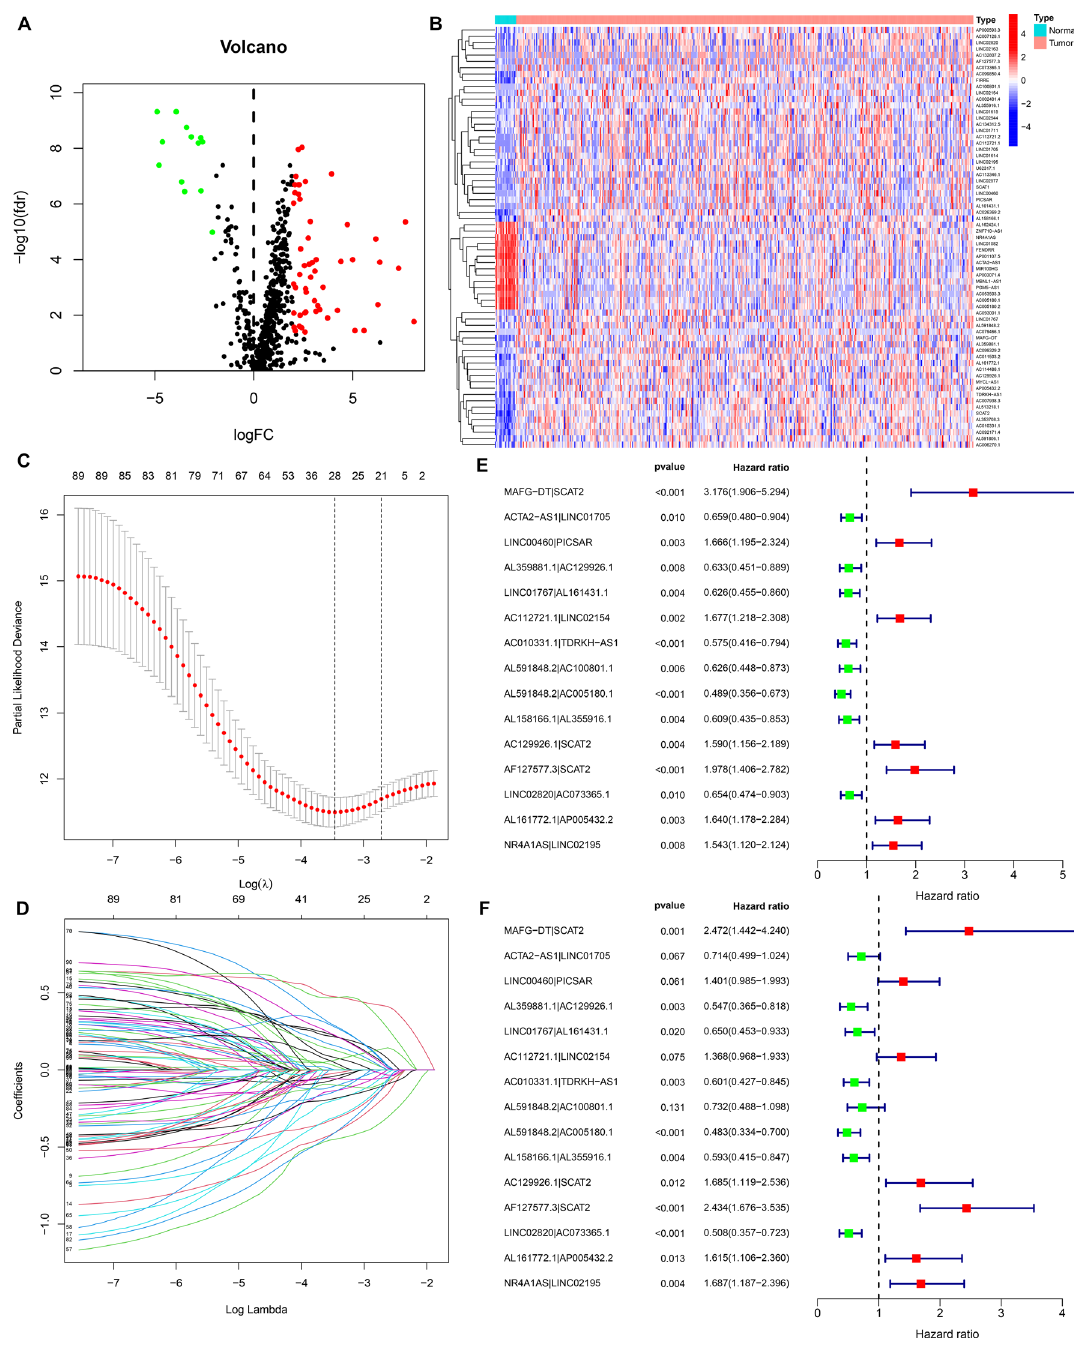
Figure 2. Developing a prognostic immune-related lncRNA signature for bladder cancer. ( A ) Volcano diagram of immune-related lncRNAs that displayed abnormal expression in bladder cancer and normal tissue specimens. Red dots: up-regulation and green dots: down-regulation. ( B ) Hierarchical clustering analyses of the dysregulated expression patterns of these immune-related lncRNAs between bladder cancer and normal tissue specimens. Red: up-regulation and blue: down-regulation. ( C ) Elucidating LASSO coefficient profiling of these prognostic lncRNAs. ( D ) Validating tuning parameter selection for LASSO regression model. ( E ) Univariate cox regression analyses of the dysregulated immune-related lncRNAs that may significantly impact bladder cancer’s survival. Red: risk factor and green: protective factor. ( F ) Multivariate Cox regression analyses of the candidate prognostic